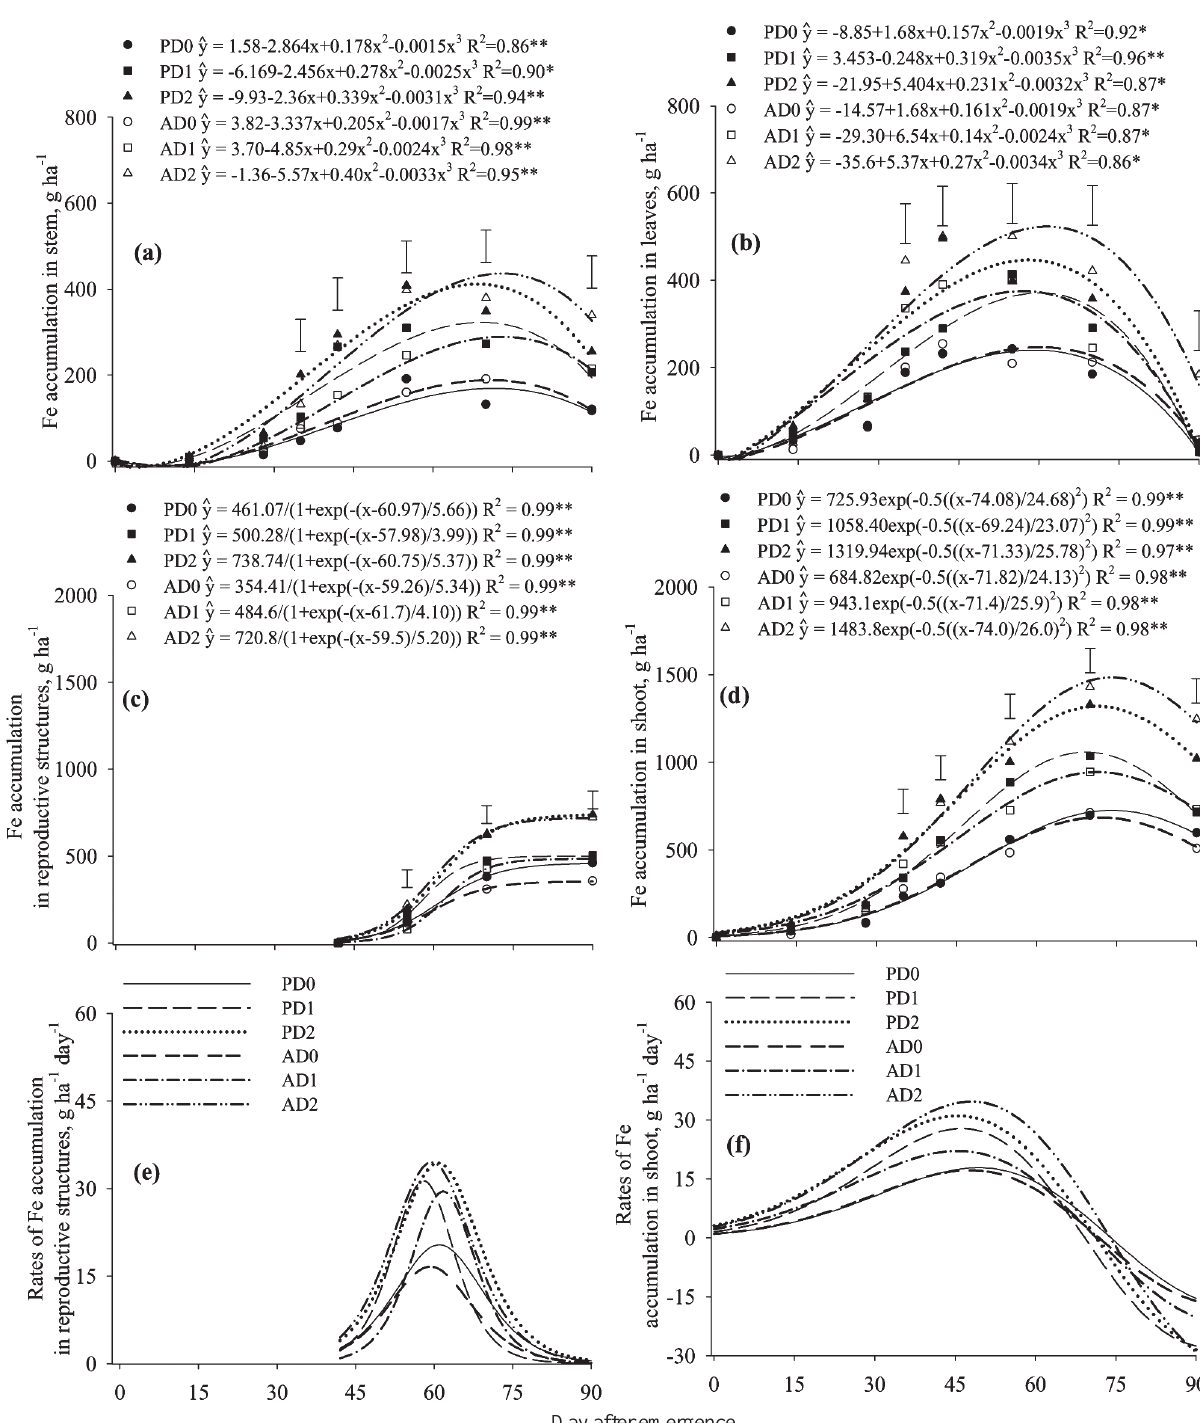
Figure 3. Iron accumulationin stem (a), leaves (b), reproductive structures (c), and shoot (d) and rates of accumulation of Fe in reproductive structures (e) and shoot (f) of common bean cultivars, under different levels of fertilization. ** and * are: significant at p 0.01 and p 0.05 by the F test. Vertical bars represent the Least Significant Difference (LSD) at p 0.05. PD0 = Pérola without NPK fertilization, PD1 = Pérola with 50 % of recommended NPK fertilization; PD2 = Pérola with 100 % of recommended NPK fertilization; AD0 = IAC Alvorada without NPK fertilization, AD1 = IAC Alvorada with 50 % of recommended NPK fertilization; AD2 = IAC Alvorada with 100 % of recommended NPK